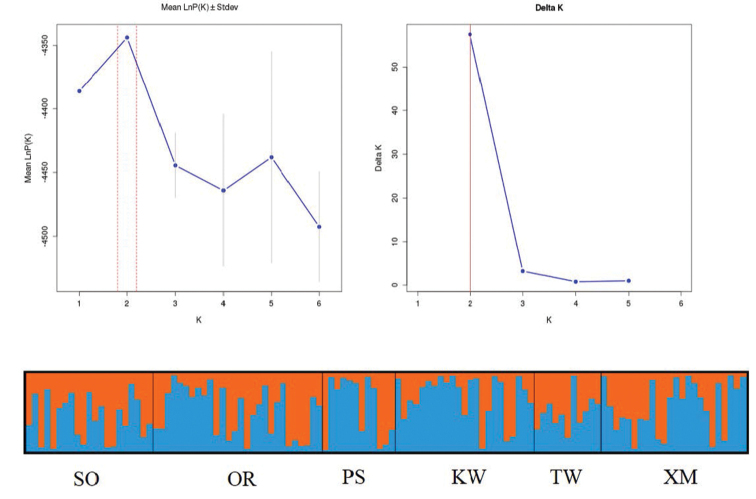
Results of the STRUCTURE analysis from seven microsatellite loci in P.argenteus (K = 2). Vertical lines are proportional to the probability of individual membership in the simulated cluster. Abbreviations: SO: Sonmiani Bay, OR: Ormara, PS: Pasni, KW: Kuwait, TW: Taiwan, XM: Xiamen.